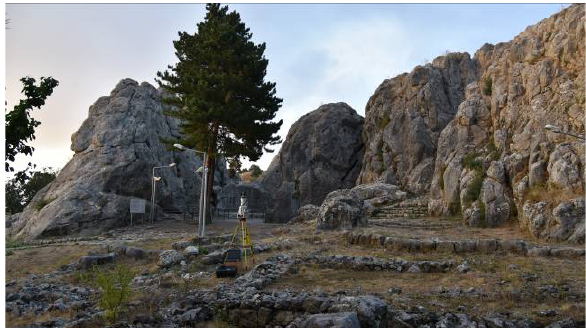
Figure 1. The rocky complex of Yazılıkaya On the south-west front of the rocky complex, from which the larger internal area defined as “Chamber A” was accessed,